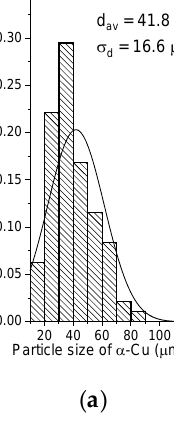
Figure 3. The matrix grain size distributions in 5% Ud ( a ), 10% Ud ( b ), 15% Ud ( c ) and 25% Ud ( d ) alloys.